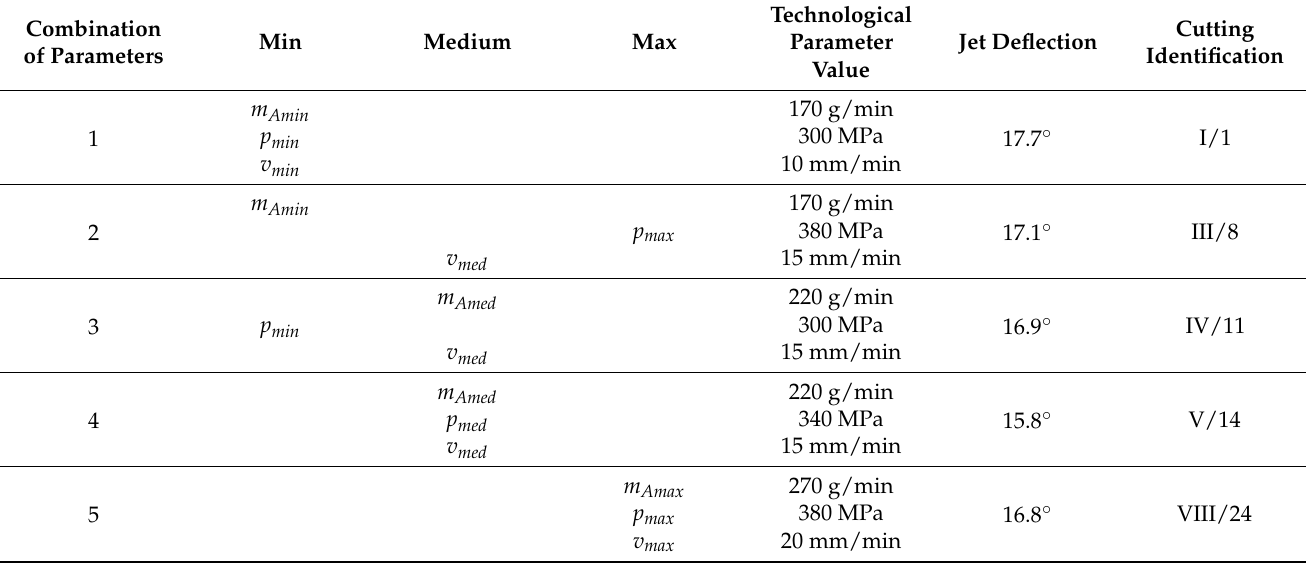
Table 5. Combinations of technological parameter values selected from the evaluated ranges that have a similar effect to achieving approximately the same deflection of the abrasive water jet Ø (16.8 ◦ ).